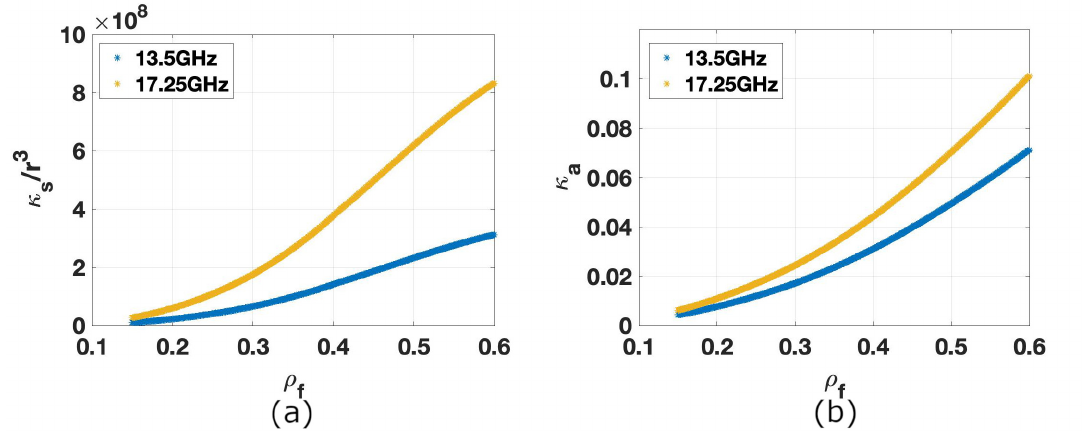
Figure 8. ( a ) Snow scattering coefficient normalized by grain radius vs. snow density and ( b ) snow absorption coefficient vs. snow density. Green and orange are the results for 13.5 and 17.25 GHz,